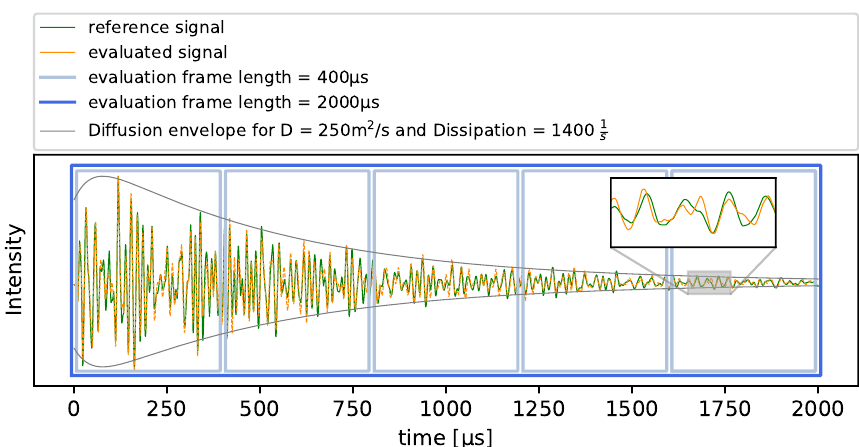
Figure 1. Example signal (60 kHz) with the used evaluation windows and envelope fitting with the solved diffusion